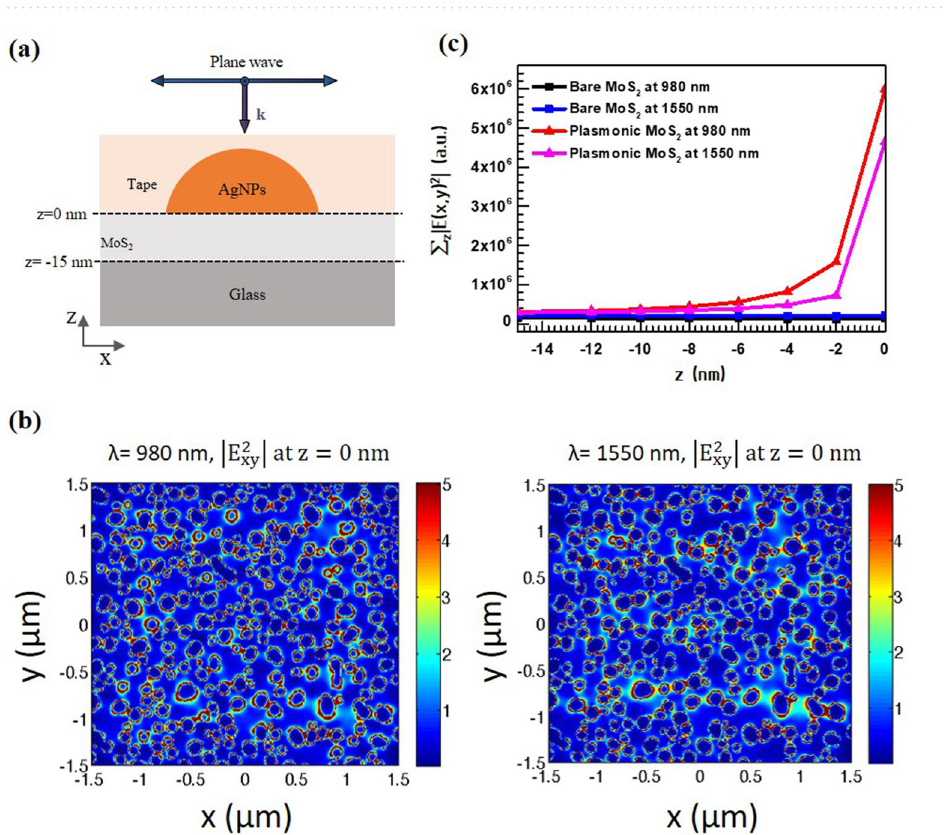
Figure 5. ( a ) Schematic illustration of the modeling geometry used in the FDTD numerical simulation. ( b ) E-field intensity profiles in the XY plane at the interface between AgNPs and MoS 2 (i.e., z = 0 nm) when the wavelength of the incident light is 980 nm and 1,550 nm. ( c ) A plot of the integrated electromagnetic field intensity in the XY plane along the z -axis (∑ z |E(x,y) 2